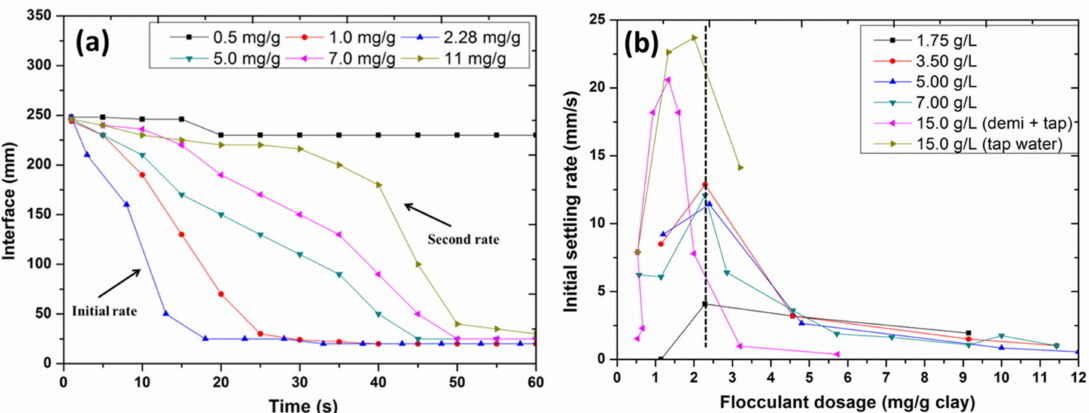
Figure 9. ( a ) Clay–water interface as a function of time for 7 g / L clay suspensions in the presence of anionic polyelectrolyte for various flocculant to clay ratios (mg / g) and ( b ) initial settling rate (initial slope) as a function of flocculant to clay ratio (mg / g) for di ff erent clay suspensions in the presence of the anionic